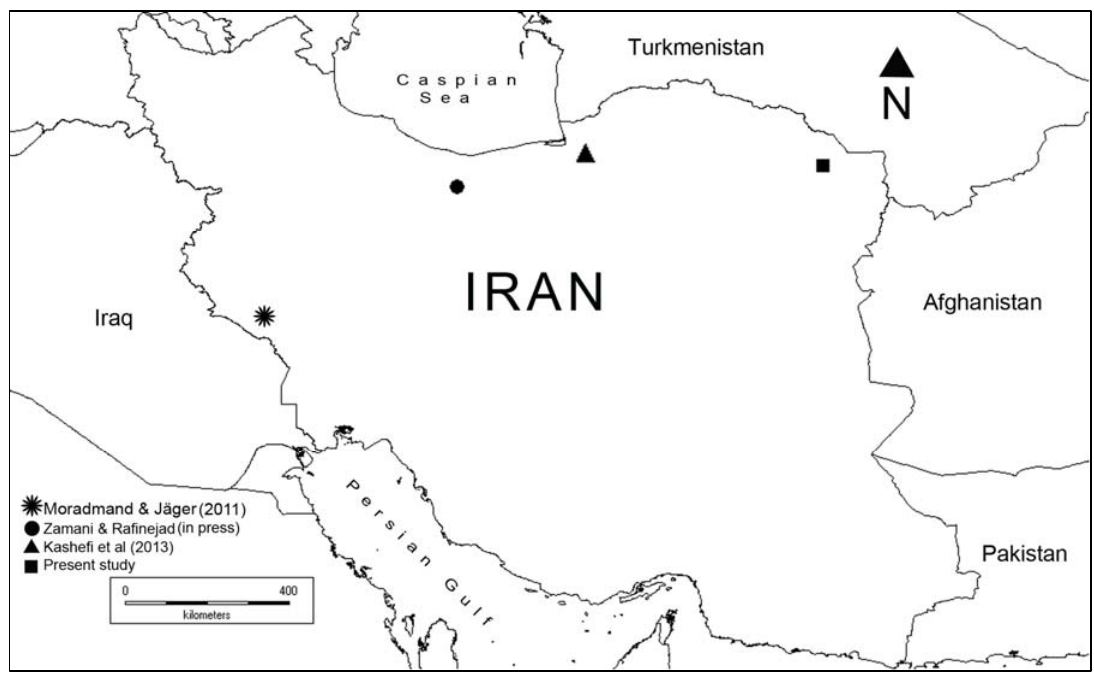
Figure 5 . Recorded occurrence of the genus Loxosceles Heineken & Lowe, 1832 in